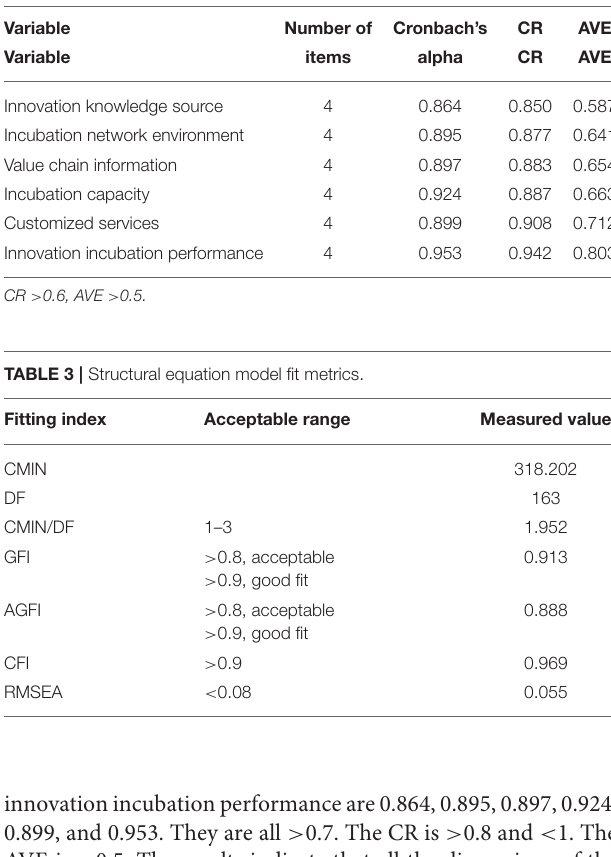
TABLE 2 | Reliability and validity analysis results.